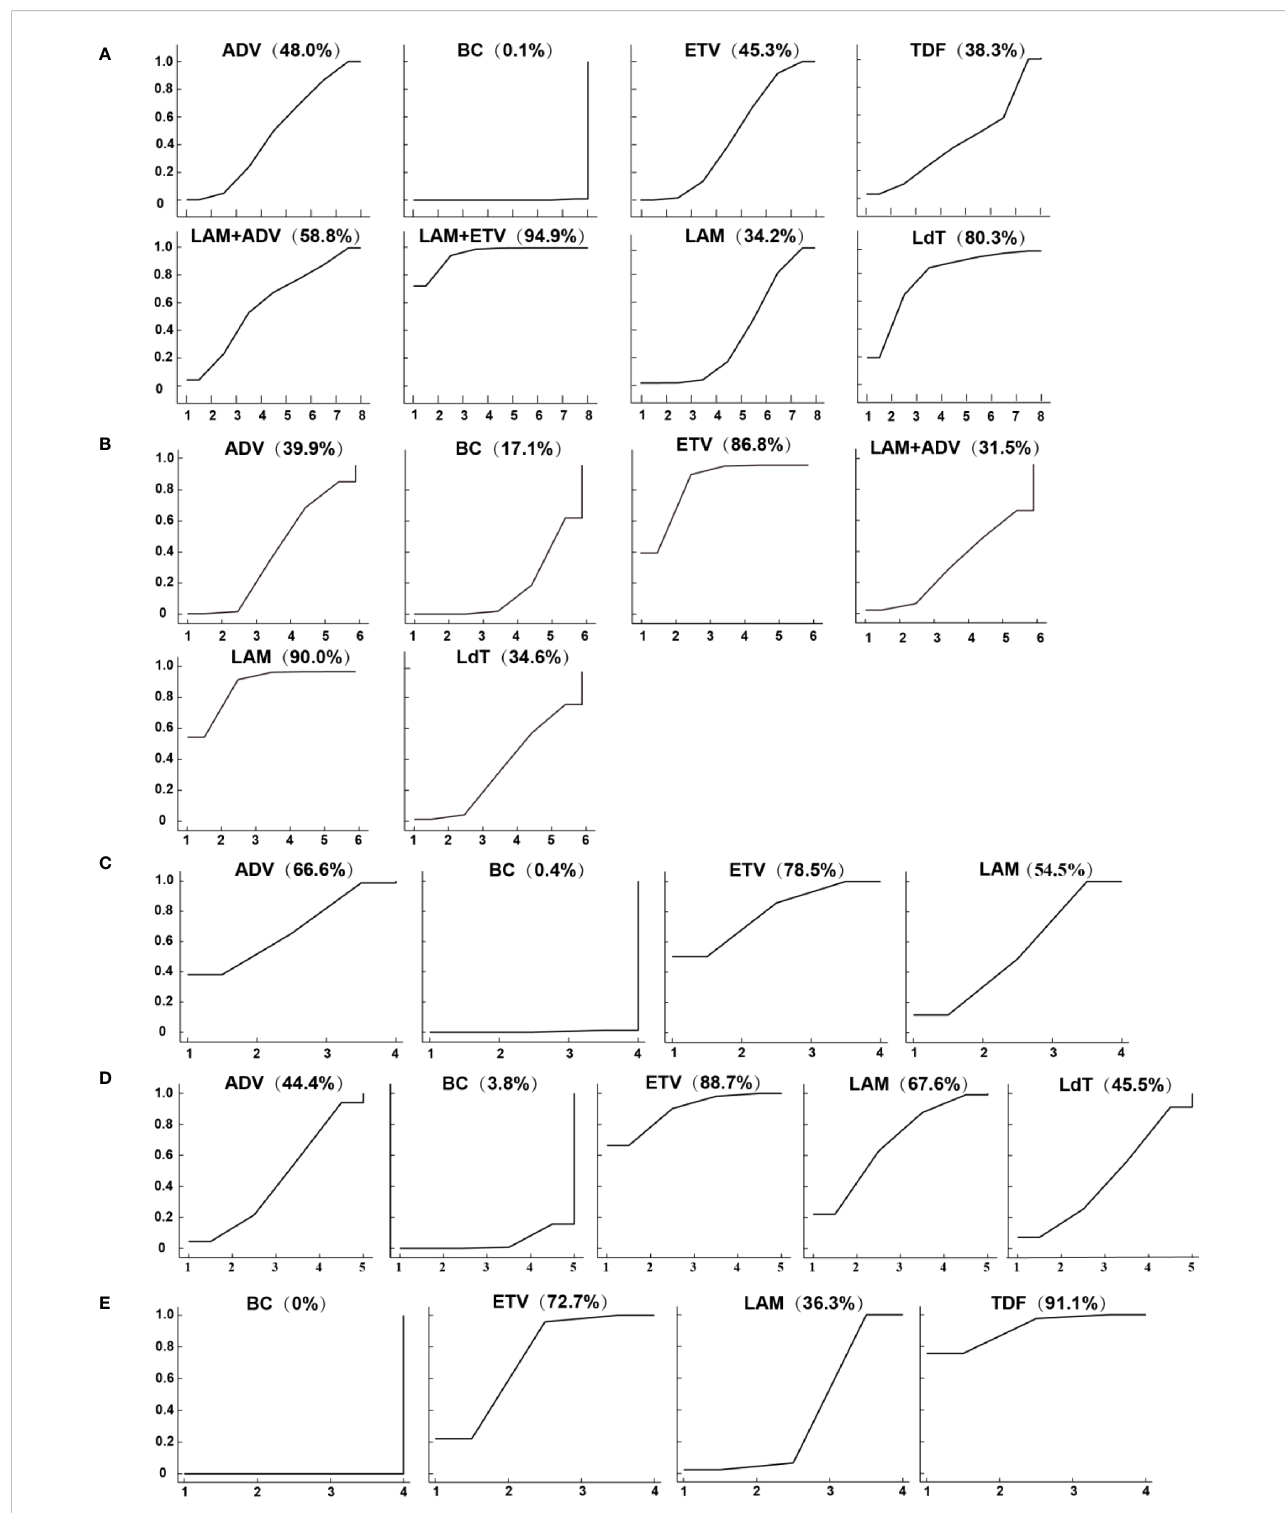
FIGURE 3 Surface under the cumulative ranking curves (SUCRAs) for (A) the HBV reactivation rate, (B) 1-year survival rate (C) 2-year survival rate (D) 3-year survival rate, and (E) chemotherapy disruption